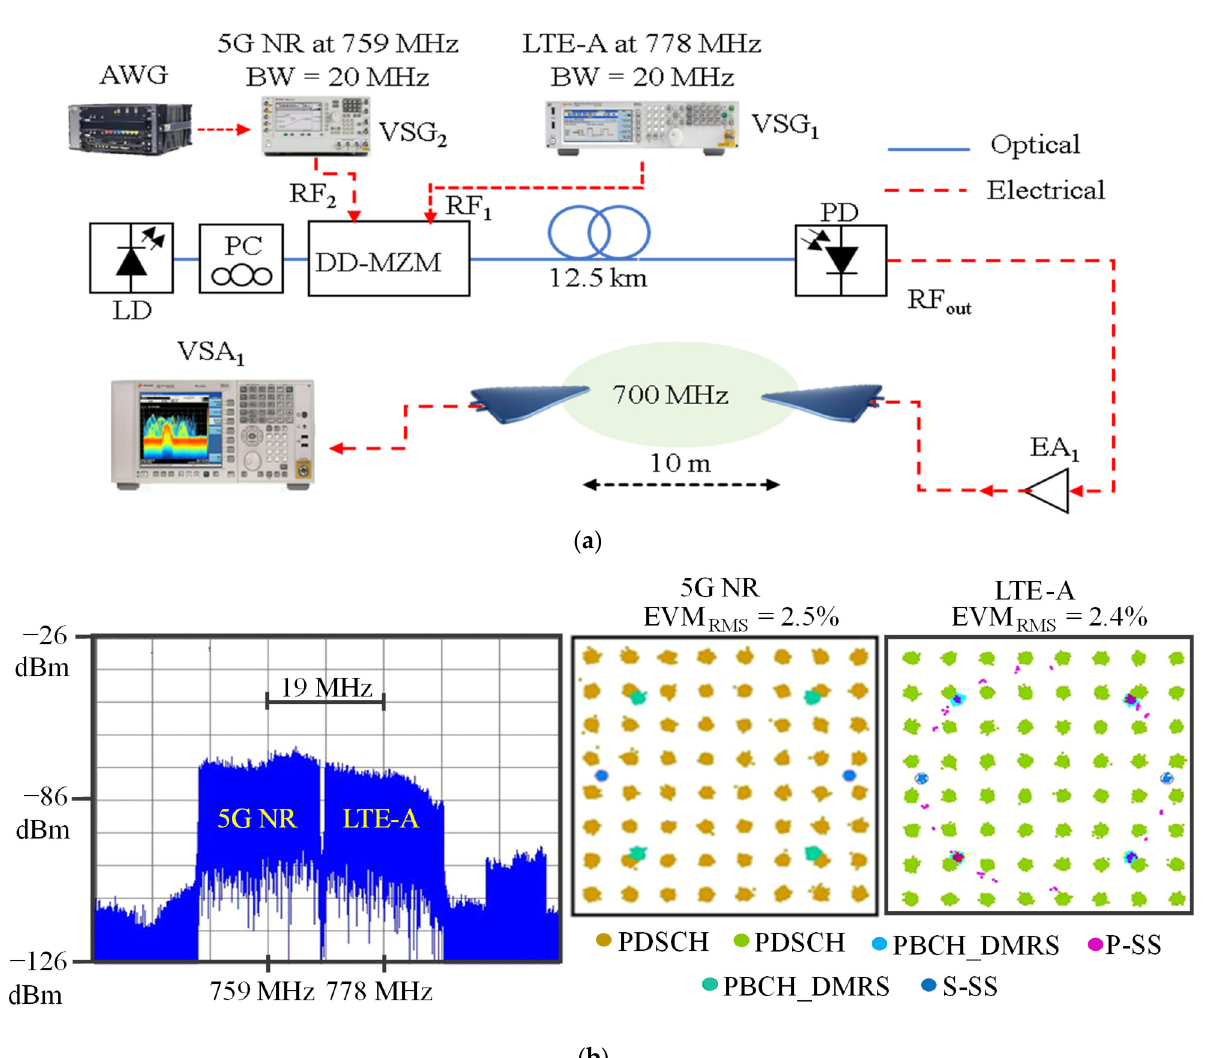
Figure 3. The 4G/5G NR fiber-optic-based fronthaul architecture. ( a ) Block diagram; ( b ) coexistence analysis between 4G and 5G technologies in the optical-wireless system.